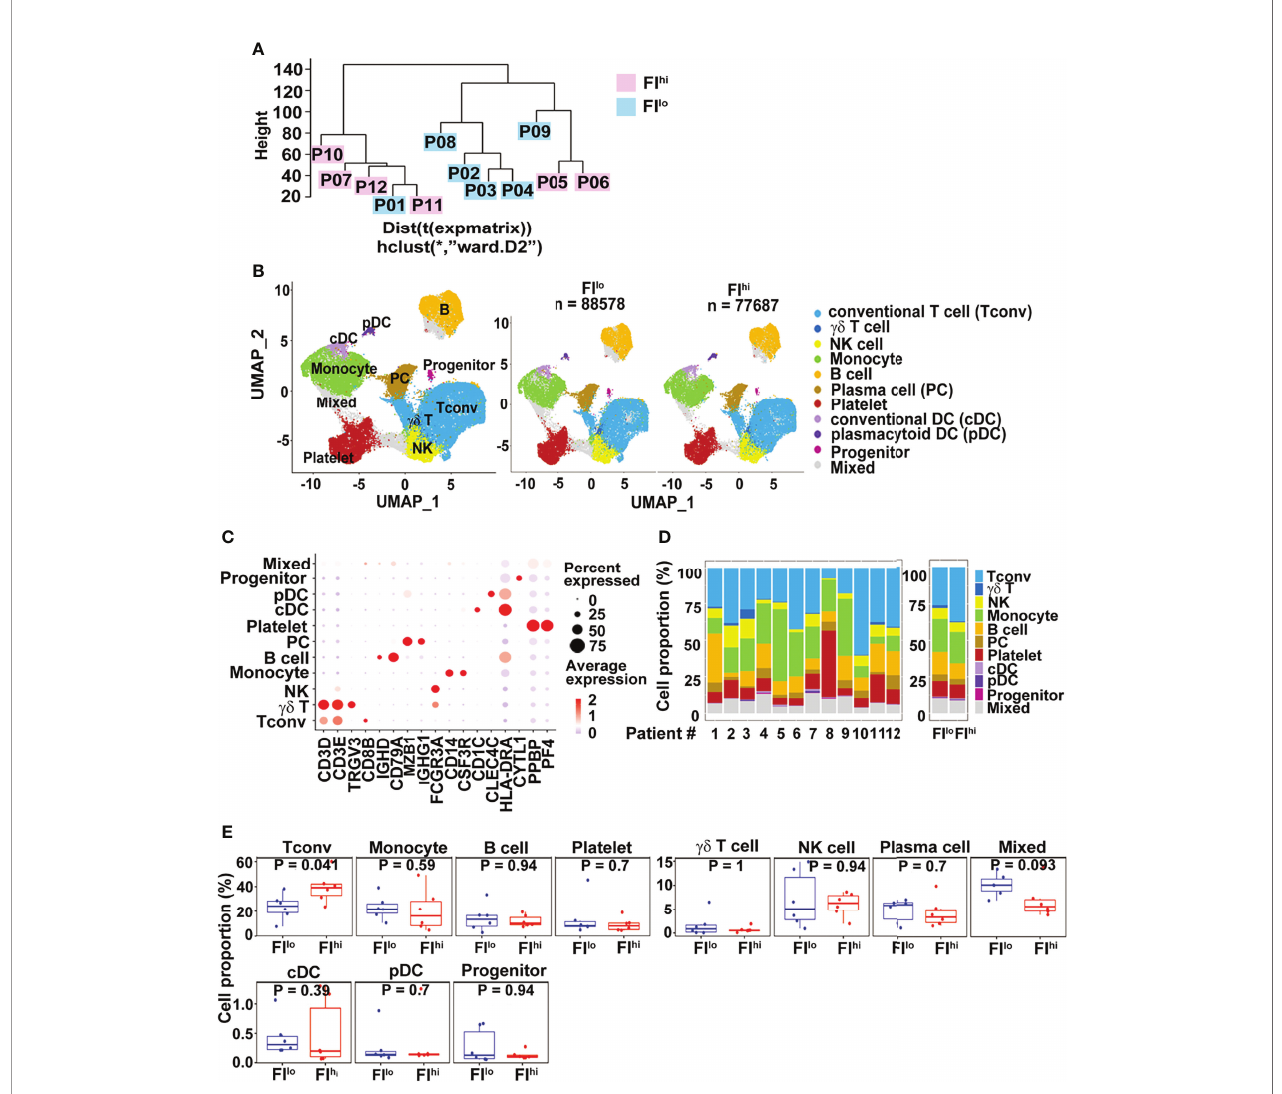
FIGURE 1 | Increased CD3 + conventional T cells in FI hi patients with severe COVID-19. (A) Pseudo-bulk analysis and clustering of the samples collected from 12 patients with severe COVID-19. The patients were evaluated by chest CT imaging system at discharge, and FI values were given. Based on the median value (0.0567) of FI, the patients were divided into two groups, FI lo (P01-04, P08-09) and FI hi (P05-07, P10-12). (B) UMAP visualization of PBMC clusters. (C) . Dot plot showing the row-scaled expression of selected signature genes for each cluster. (D) Cell composition varied among all patients studied. (E) . Increased conventional T-cell proportion in FI hi